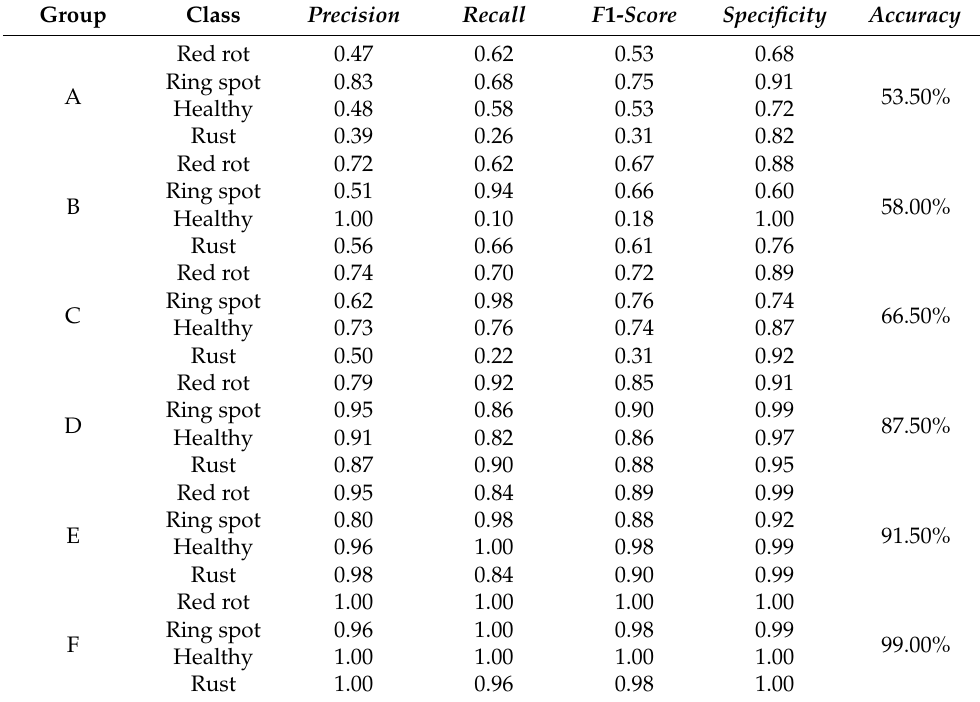
Table 9. Performance comparison of MobileNetV3-Large trained by the four groups of samples. Group Class Precision Recall F 1- Score